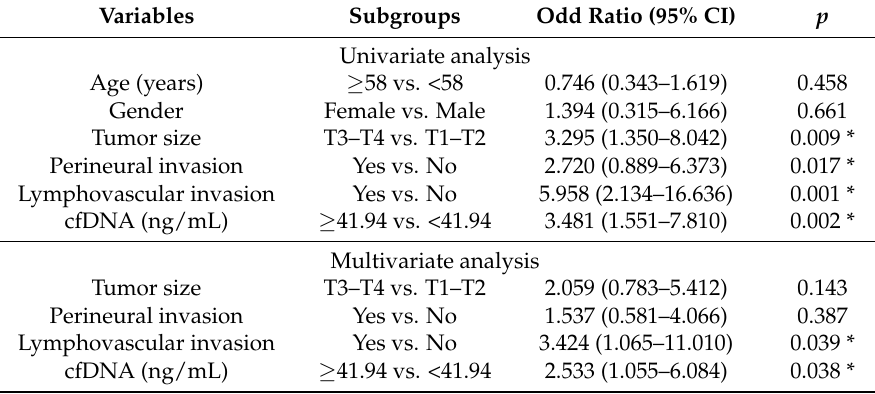
Table 3. Univariate and multivariate analysis of risk factors for lymph node metastasis.